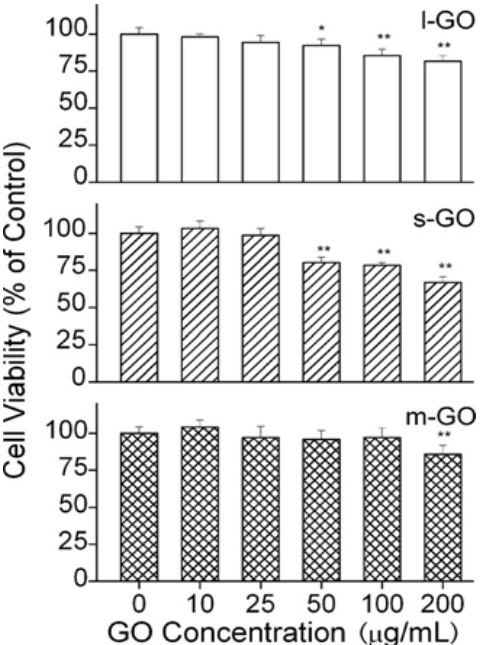
Figure 8. The effects of graphene oxide (GO) doses and sizes on the viability of A549 cells. Reproduced from [46] with permission of Elsevier. * and ** denote p < 0.05 and p < 0.01 vs. the control, respectively.